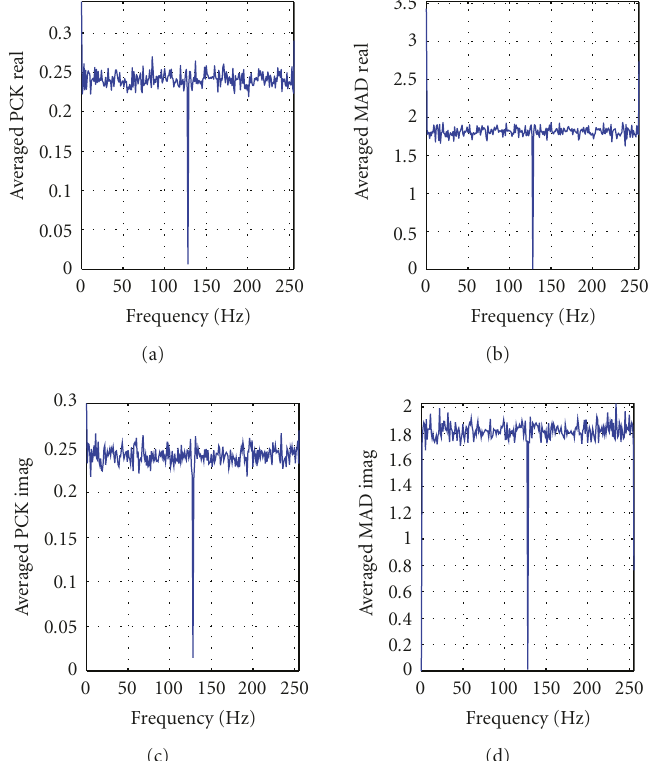
Figure 10: The plots of PCK RE ( p ) (a) and PCK IM ( p ) (c), MAD RE ( p ) (b) and MAD IM ( p ) (d) for FM signal s 2 ( n ) corrupted by S α S noise with α = 1 . 5 and γ =